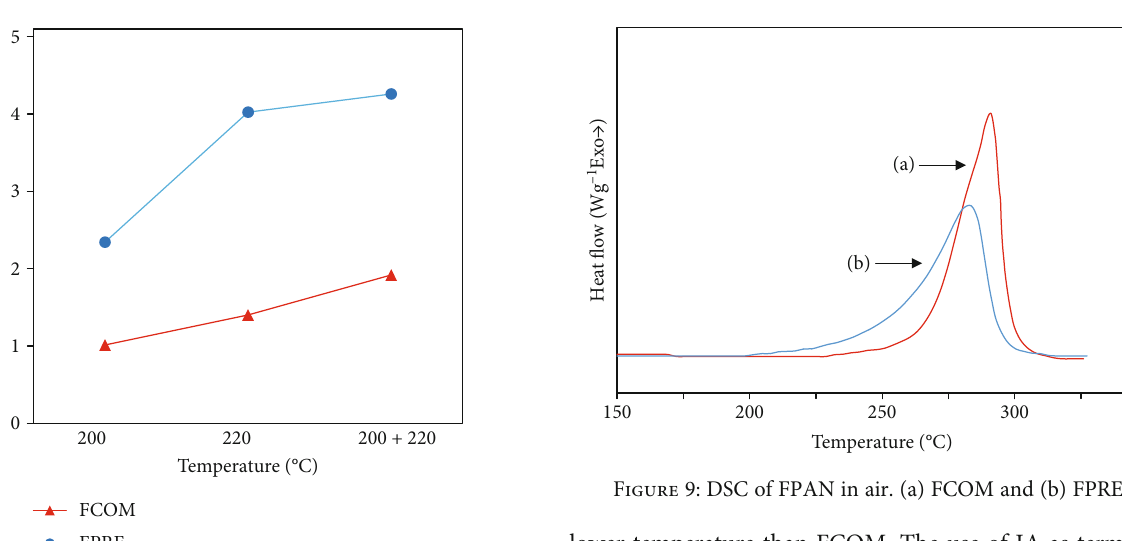
Figure 7: FTIR spectra of precursor fi ber heated at di ff erent temperatures: (a) FCOM, and (b)